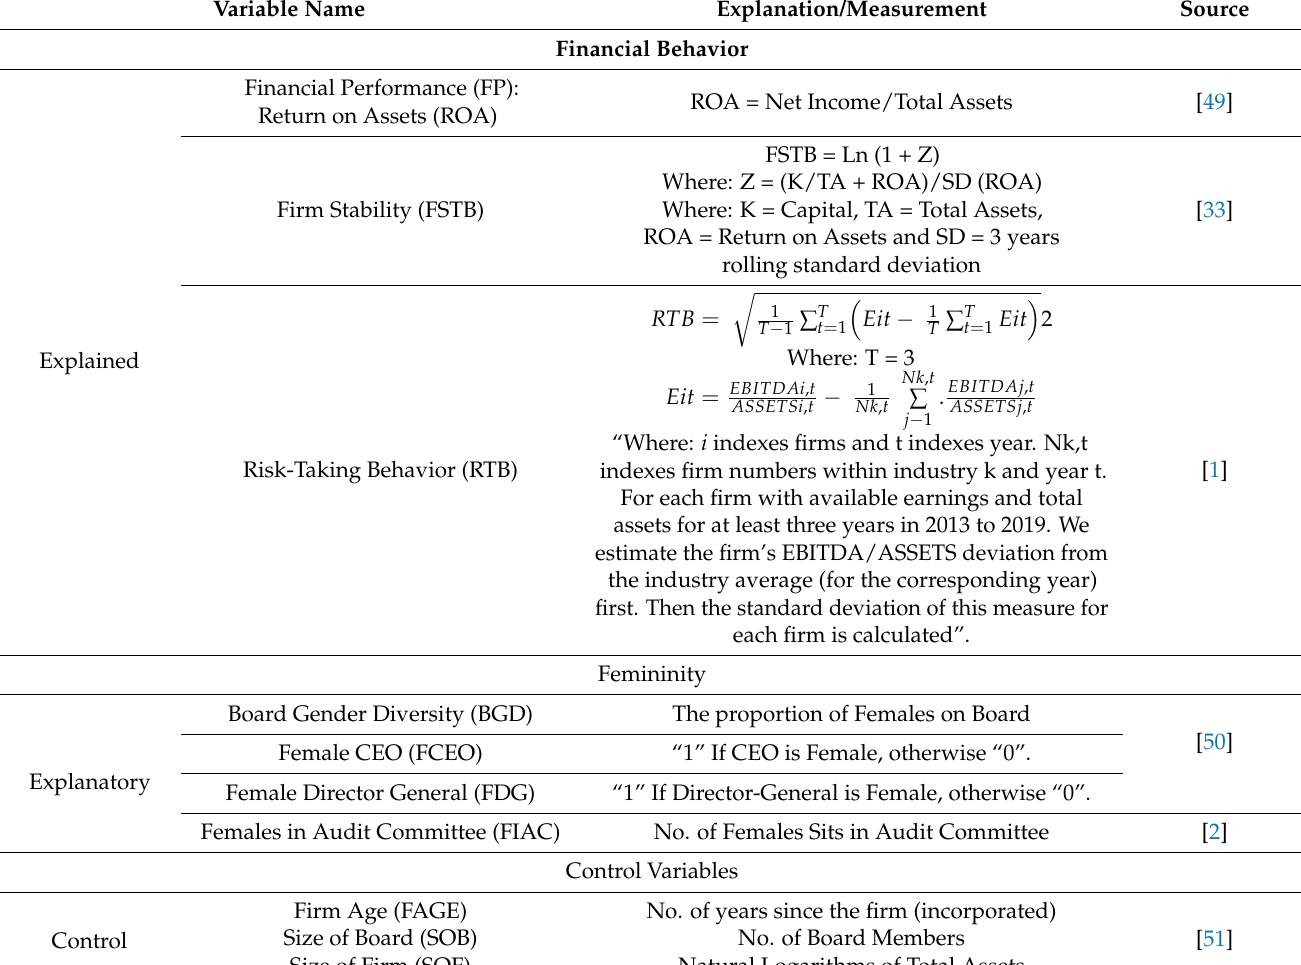
Table 2. Variables